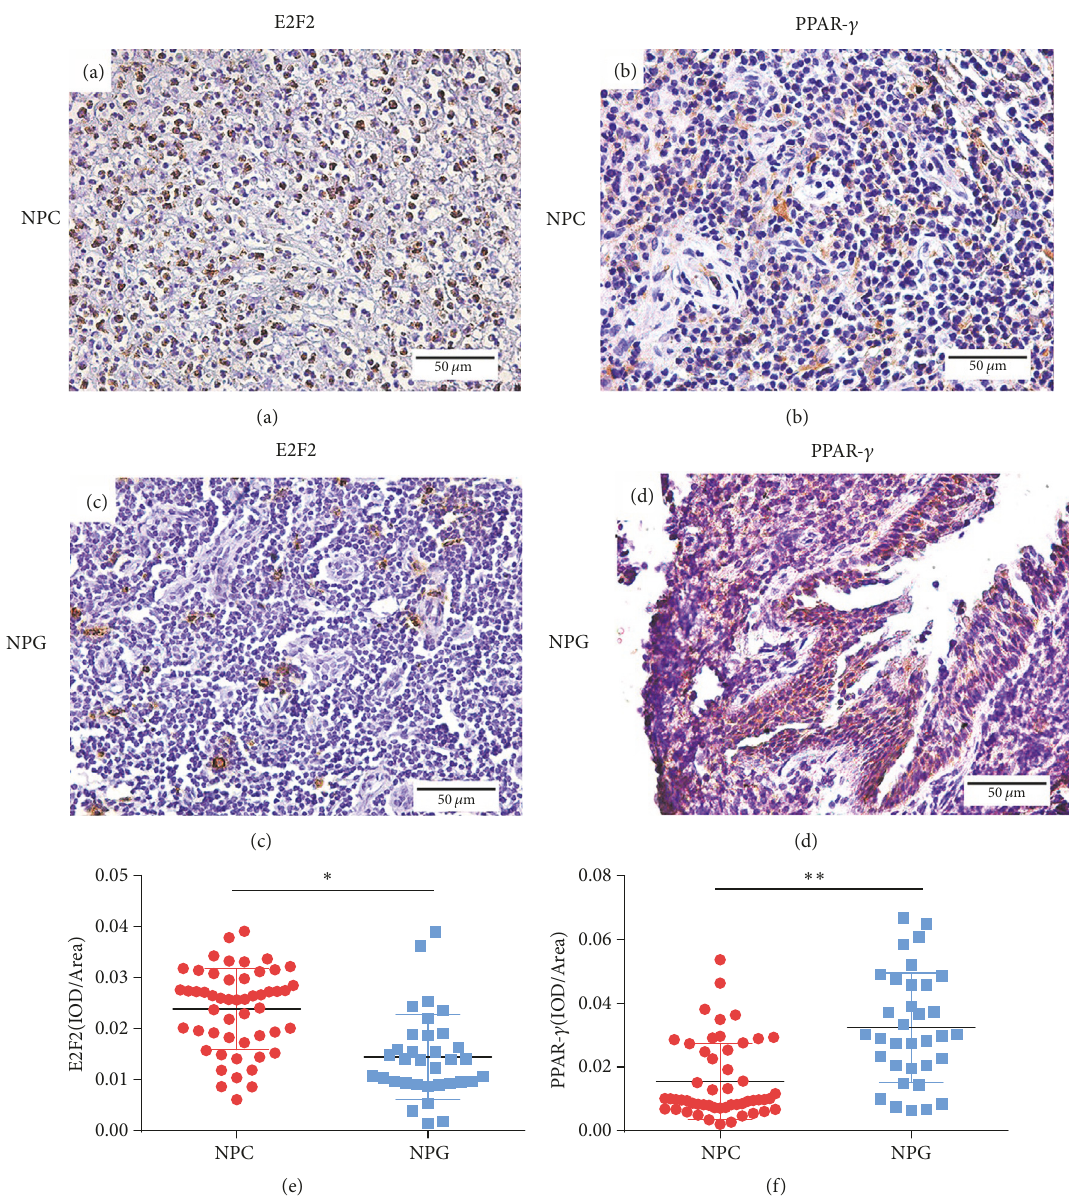
Figure 1: E2F2 and PPAR- 𝛾 protein expression in nonkeratinizing nasopharyngeal carcinoma (NPC) and nasopharyngitis (NPG) tissues . Immunohistochemistrywas performed to detect E2F2 and PPAR- 𝛾 protein expression in nonkeratinizing NPC tissues (a, b) and NPG tissues (c,d).Scalebar,50 𝜇 m(e,f).TheimmunohistochemistrydatawereanalyzedsemiquantitativelytodeterminetheE2F2andPPAR- 𝛾 expression levels in nonkeratinizing NPC and NPG tissues. Data are shown as means ± standard deviations. ∗∗ P <